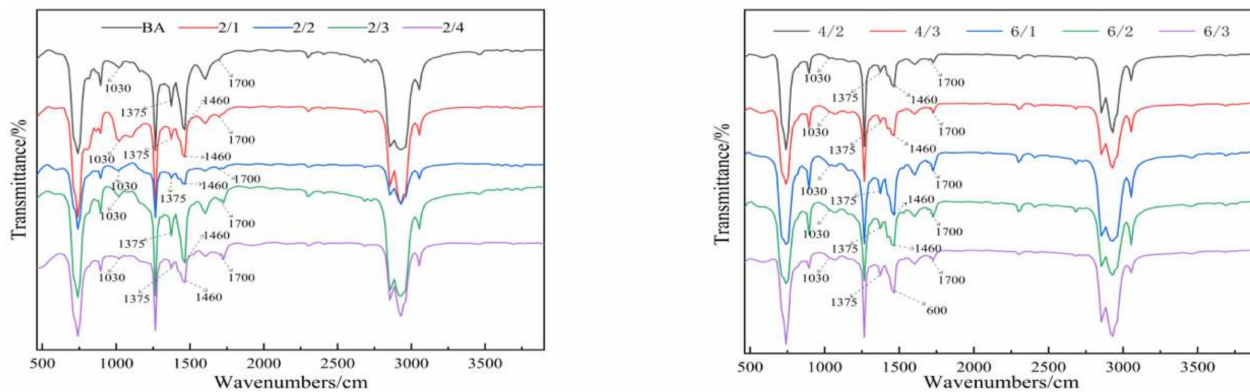
Figure 11. Infrared spectrum of asphalt after